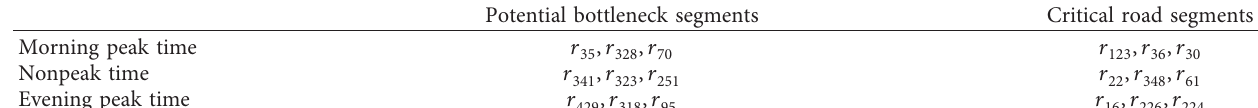
Table 3: Potential bottleneck segments and critical road